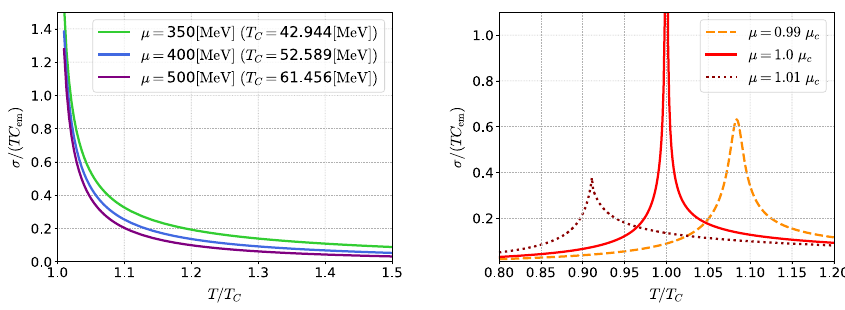
Figure 3: The electric conductivity σ assosiated with the soft modes. Left : T dependence of σ assosiated with the diquark soft modes for μ = 350 MeV, 400 MeV and 500 MeV [2]. Right : T dependence of σ assosiated with the soft modes of the QCD CP for μ/μ CP = 0 . 99, 1 . 0 and 1 . 01